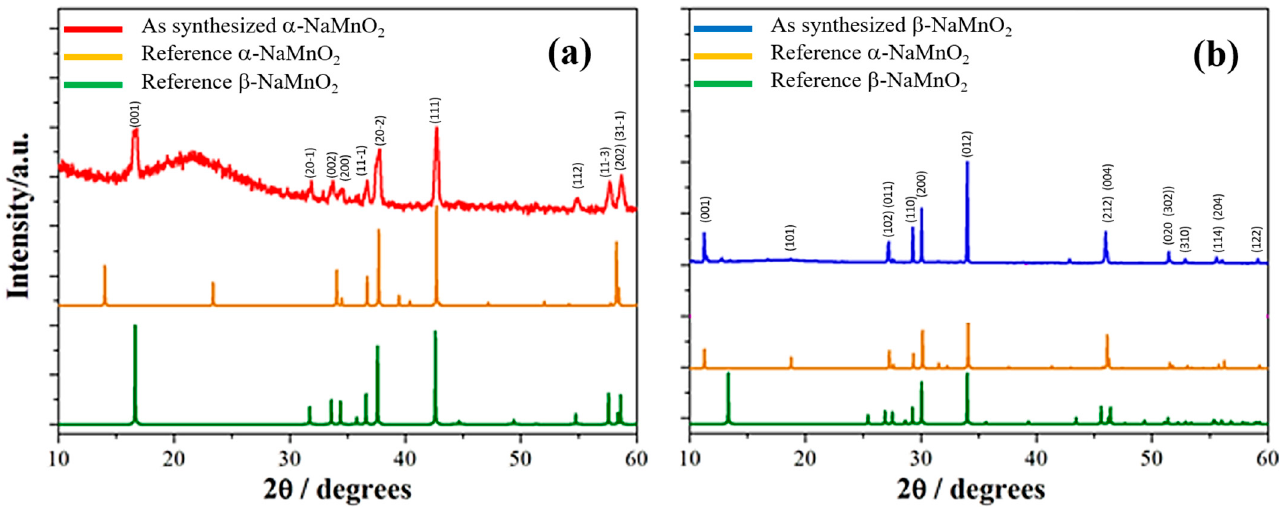
Figure 2. X-ray diffraction (XRD) patterns of the as-synthesized samples: ( a ) α -NaMnO 2 conventional XRD ( λ = 1.54 Å); ( b ) β -NaMnO 2 synchrotron radiation XRD ( λ = 1.24 Å).